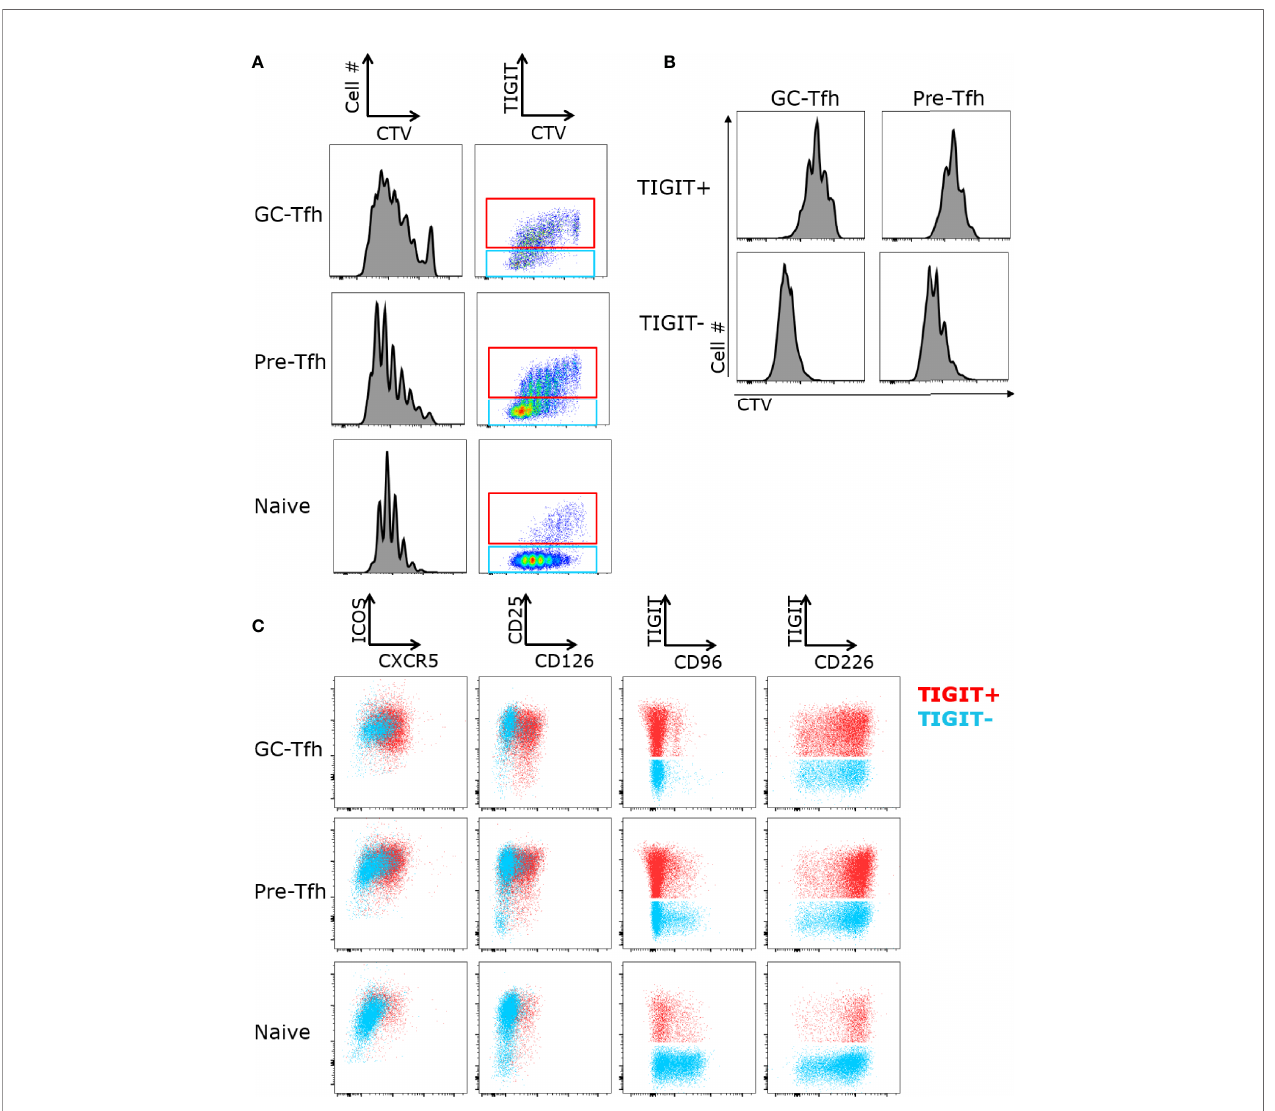
FIGURE 2 | TIGIT + Tfh cells proliferate less upon stimulation. (A) FACS-sorted GC-Tfh, pre-Tfh, and naïve cells from tonsils were labeled with Cell Trace Violet (CTV) and stimulated with anti-CD3 and anti-CD28 for 5 days. Cell proliferation and TIGIT expression was analyzed by fl ow cytometry. (B) Proliferation of TIGIT+ and TIGIT- subsets of GC-Tfh and pre-Tfh cells cultured with SEB-pulsed B cells for 5 days. (C) Expression of ICOS, CXCR5, CD226, TIGIT, CD96, CD25, and CD126 on sorted GC-Tfh, pre-Tfh and naïve T cells stimulated with anti-CD3 and anti-CD28 for 3 days. Gated to TIGIT + (shown in red) and TIGIT - (shown in blue). Representative FACS plots shown for 3